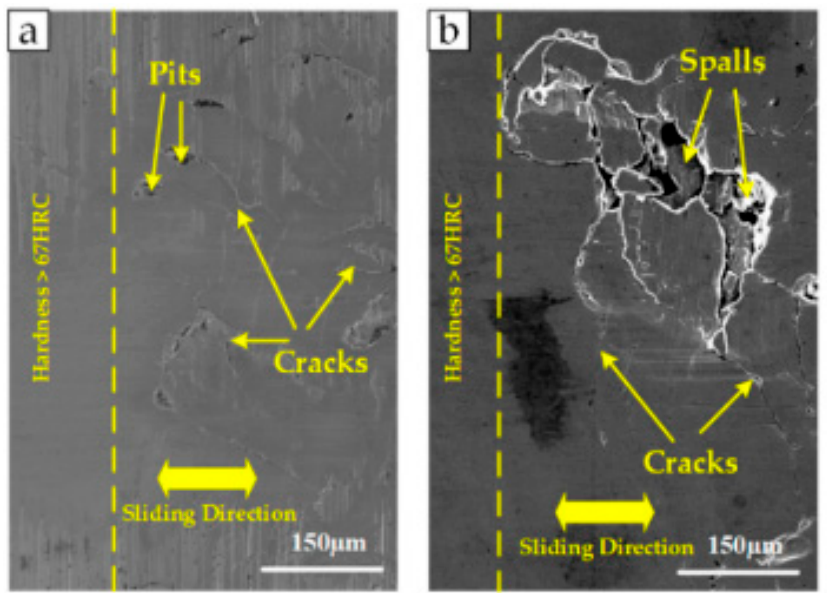
Figure 6. Worn surfaces of LHAGI and LHQTGI samples with different tempering temperatures: ( a ) 232 °C and ( b ) 316 °C (Reprinted from ref. [42])